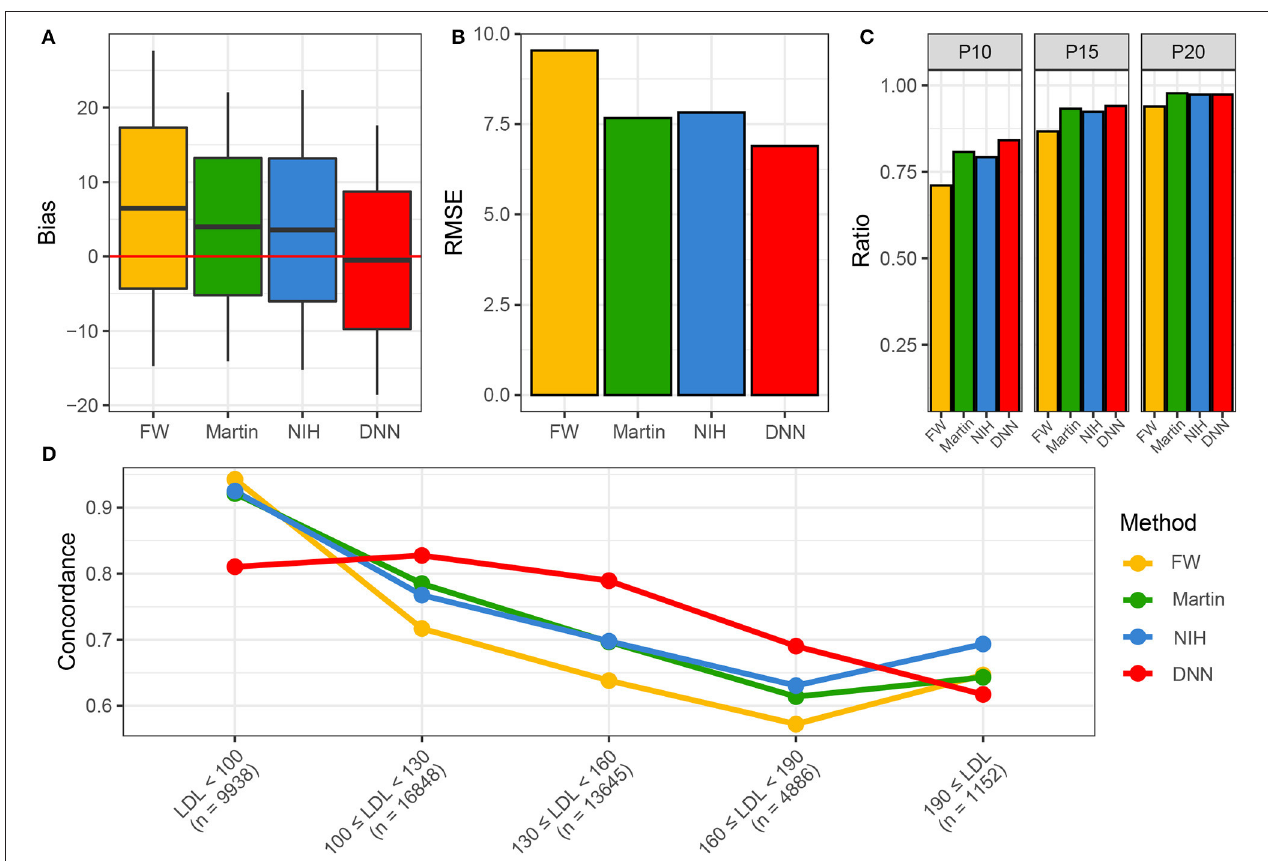
FIGURE 5 | Performances of four LDL estimation methods. (A) Bias of four LDL estimation models. (B) RMSE of four LDL estimation model. (C) P10, 15, and 20 of four LDL estimation models. (D) Concordances of four LDL estimation models. DNN, deep neural network; FW, Friedewald LDL-C; LDL, Low-density lipoprotein cholesterol; NIH, NIH equation for LDL-C; Novel, novel equation for